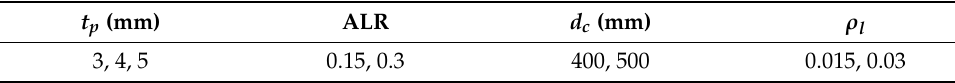
Table 1. Range of four variables in parametric study.